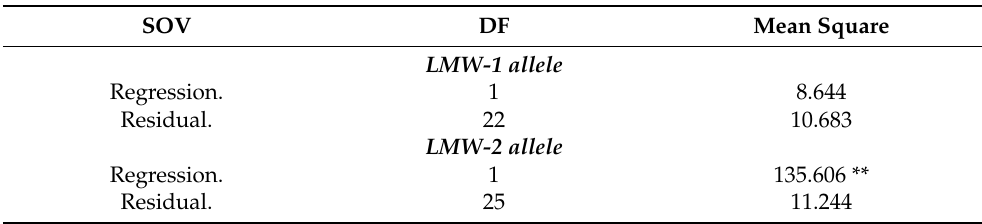
Table 5. Analysis of variance for regression of SDSS volumes on protein content in genotypes grouped based on the Glu-B3 alleles. SOV DF Mean Square LMW-1 allele Regression. Residual.